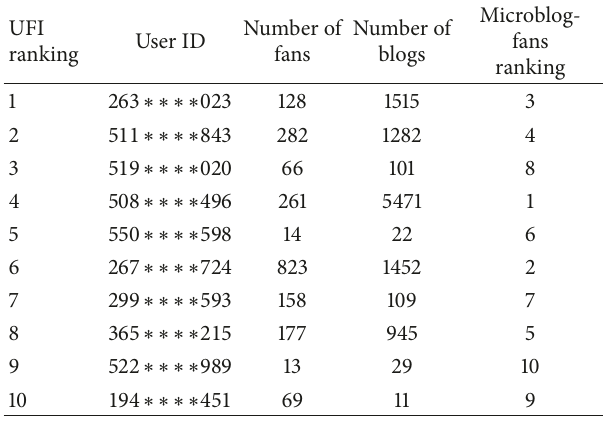
Table 8: Top 10 user information of the UFI. UFI ranking